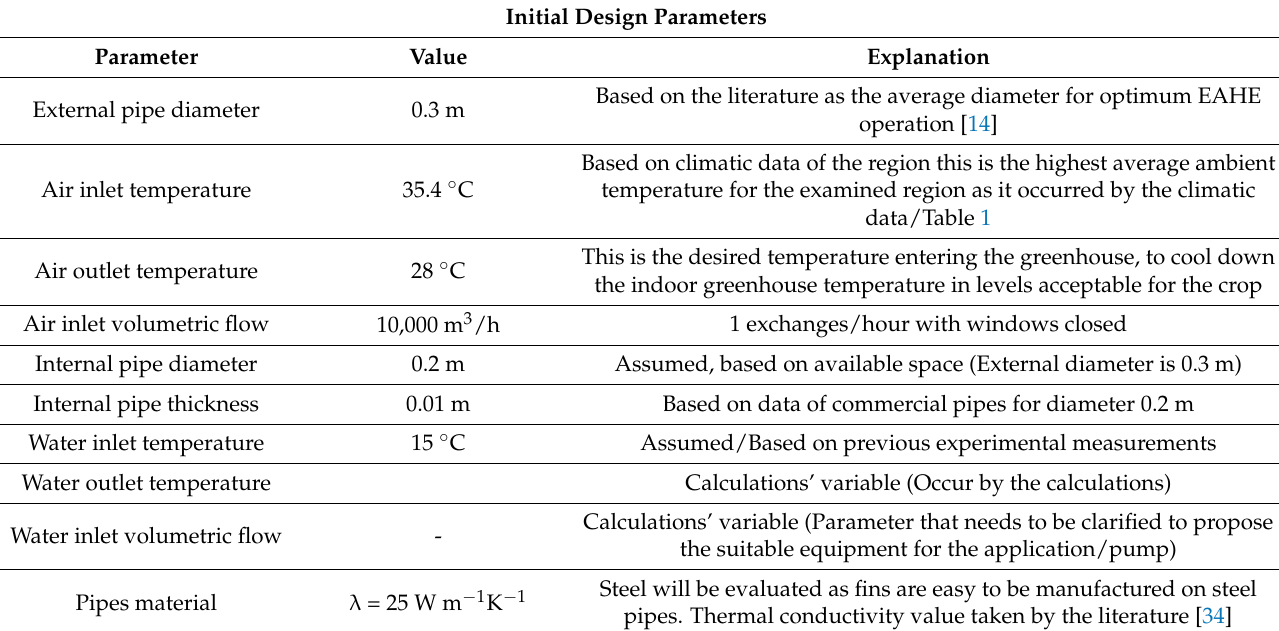
Table 2. System design